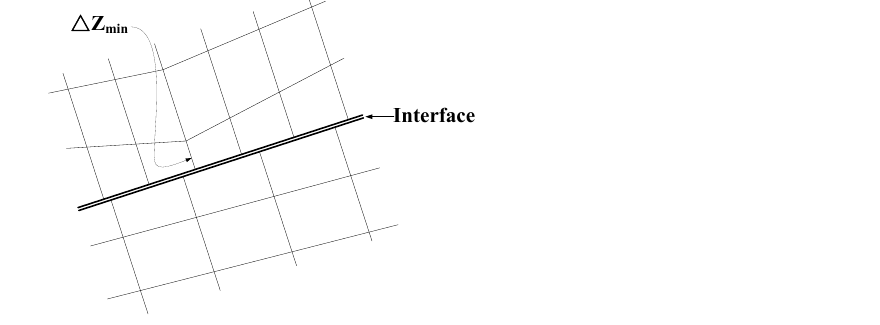
Figure 6. Schematic diagram of the minimum dimensions in the normal direction of the interface. The interface parameters to be determined include cohesion c , friction angle ϕ , tangential stiffness k s , and normal stiffness k n . The parameters related to the interface of this model are listed in Table 1. Table 1. Interface parameters.